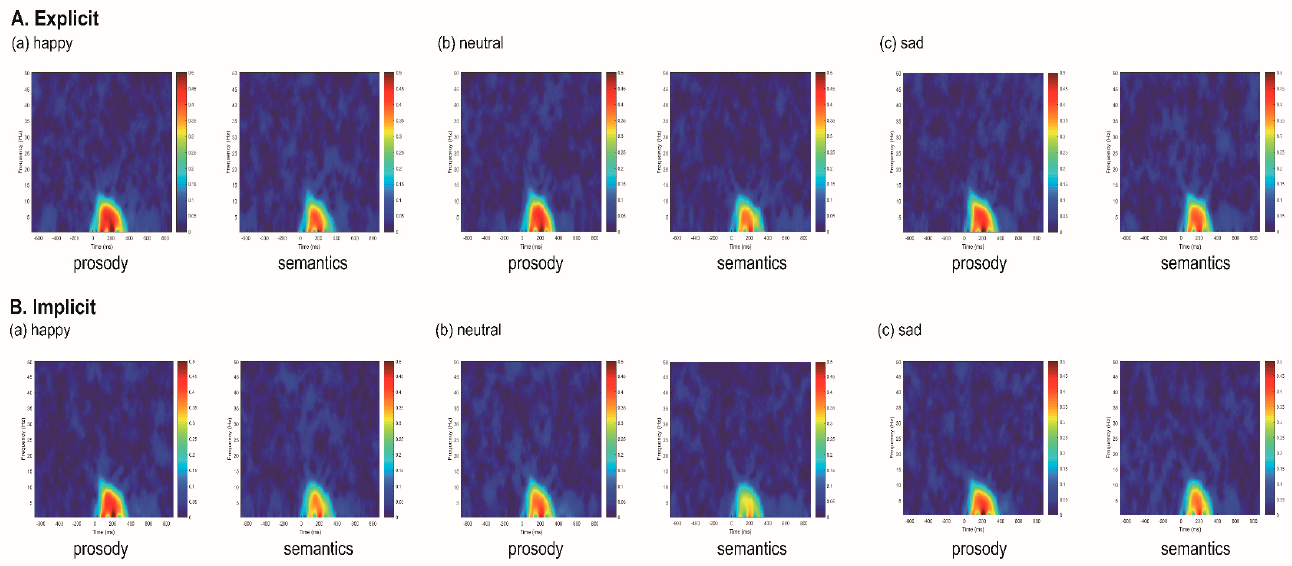
Figure 4. Time-frequency representations showing trial-to-trial phase-locking measured by ITPC for ( a ) happy, ( b ) neutral and ( c ) sad stimuli in prosodic and semantic channels across ( A ) explicit and ( B ) implicit tasks.